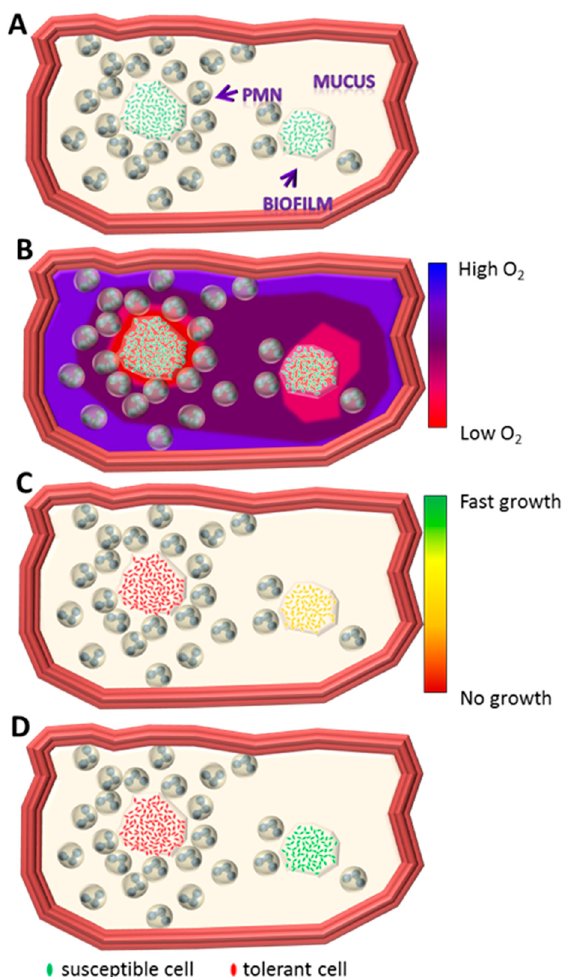
Figure 2. Schematic drawing of a biofilm-infected bronchial lumen based on ex vivo observation (Figure 1). ( A ) The bronchial lumen with two non-attached biofilms surrounded by polymorph nuclear leukocyte (PMN) infiltrated mucus; ( B ) oxygen gradient through the mucus towards the